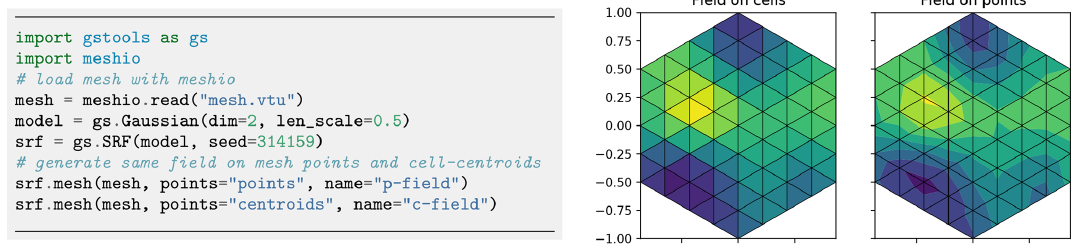
Figure 16. Generating spatial random fields on finite element method (FEM) meshes: either on cell centroids (middle) or mesh points (right). Plotting commands have been omitted.